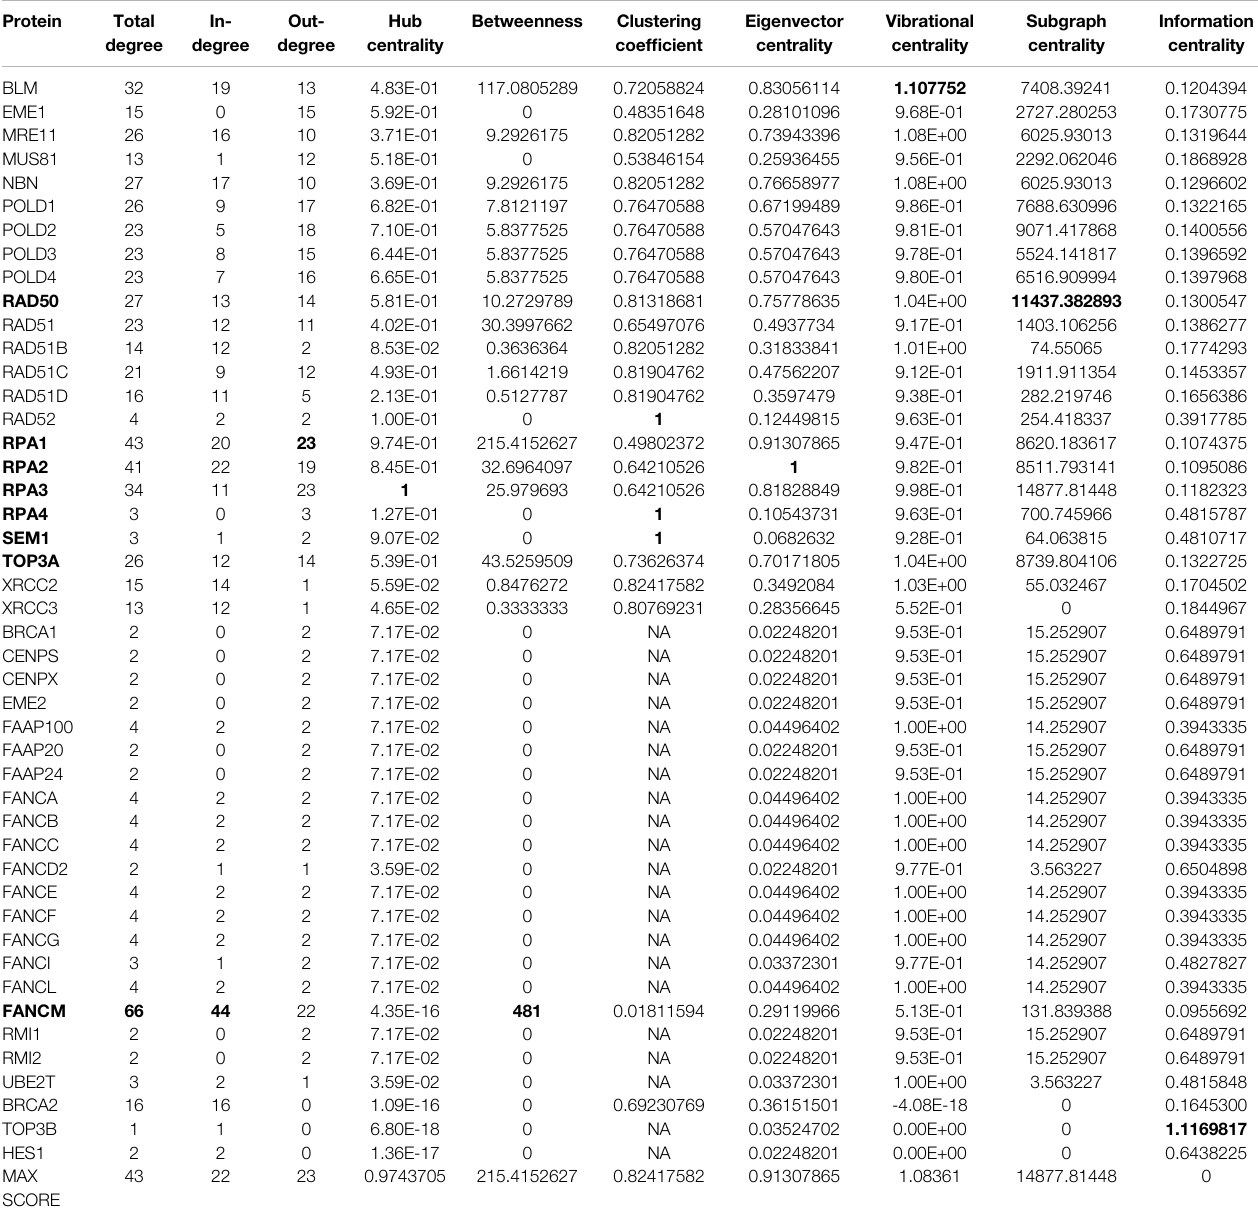
TABLE8| ValuesofthecentralitymeasuresfortheHRpathwayin(Orlic-Milacic,2015)mergedwiththeFANCMpathwayin(PathwaysCommons,2022).Inbold,wemarked the genes with the highest scores.